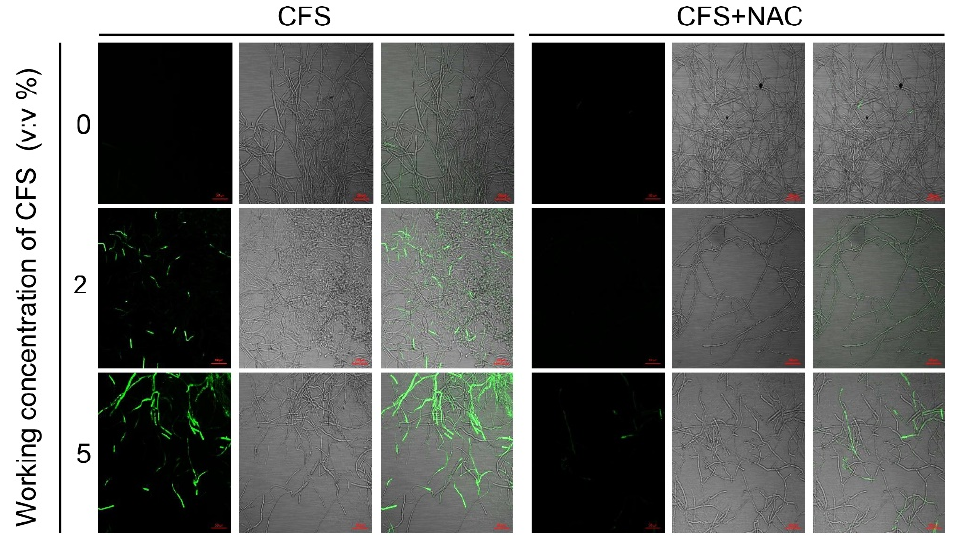
Figure 6. Effect of N-acetylcysteine (NAC) on the accumulation of reactive oxygen species (ROS) in hyphae. The culture medium was amended with different concentrations of CFS with or without 10 mM NAC, and the representative fluorescent pictures were recorded using confocal laser microscopy at 488 nm excitation and 520 nm emission.